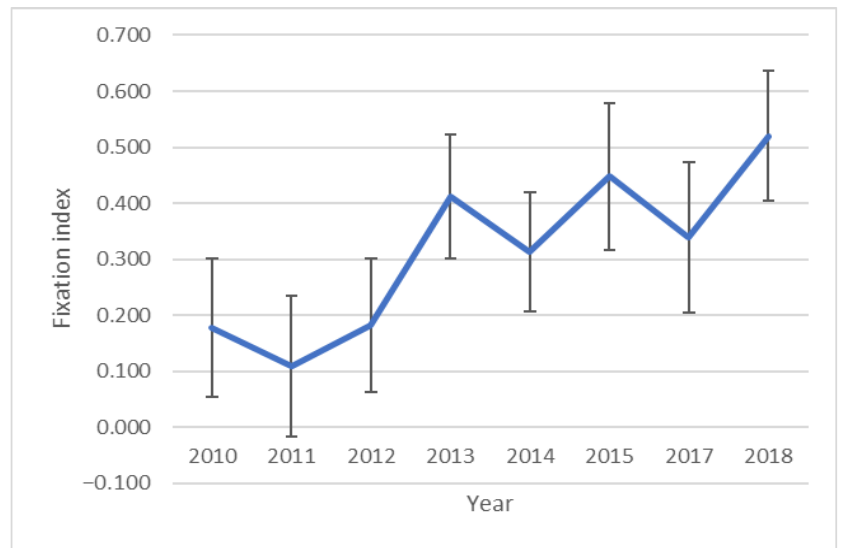
Figure 5. The change in mean F over the years for 6 main providers.